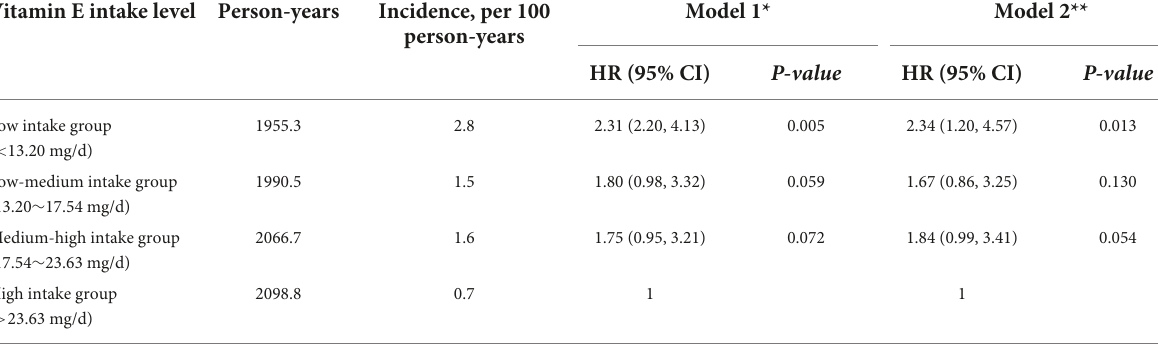
TABLE 2 Association between vitamin E intake level and risk of dementia.